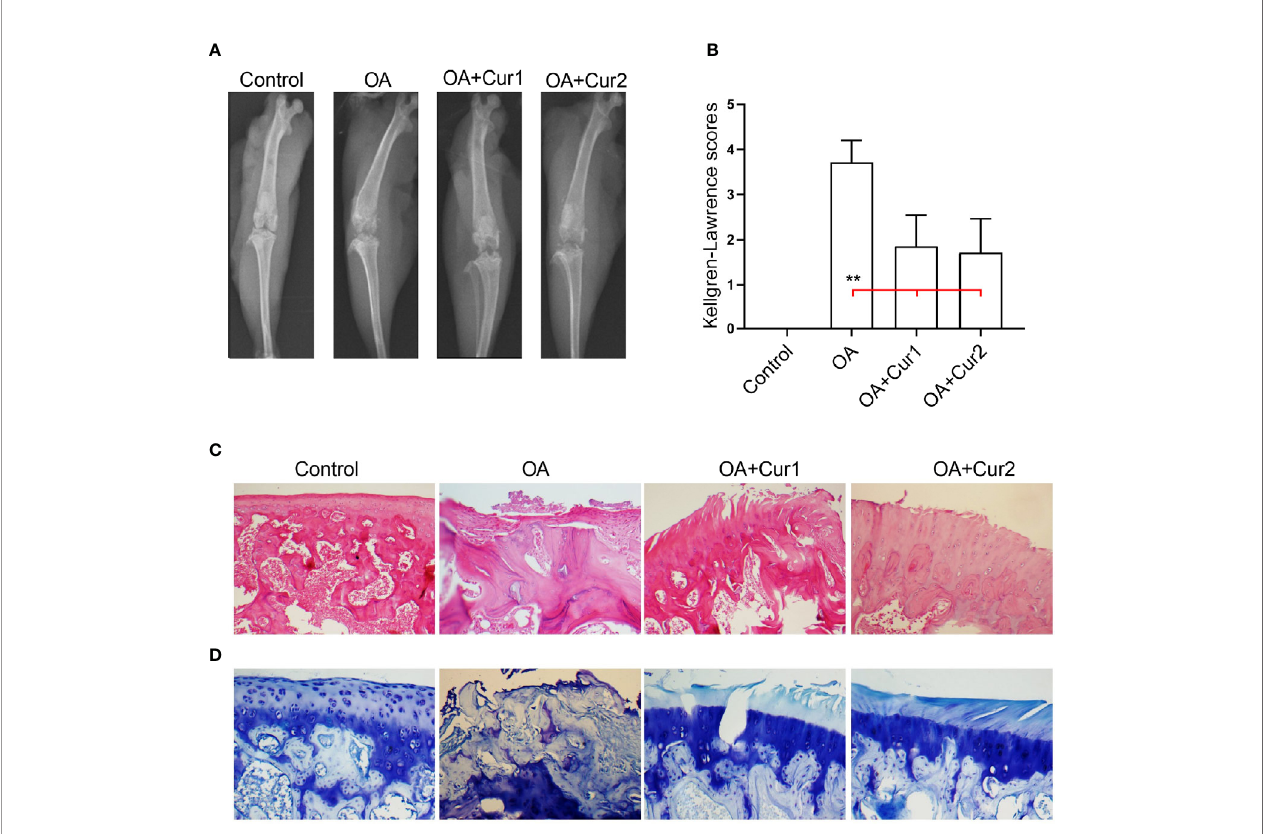
FIGURE 2 | Radiological and histological assessment of the knee joints in rats with monosodium iodoacetate (MIA)-induced OA after Next Generation Ultrasol Curcumin (NGUC) supplementation. (A) Representative radiographic images obtained at the end of the experiment are shown. (B) Mean values of Kellgren-Lawrence scores are demonstrated with ± SD (n=7 for each group). (C) Representative histopathological images of the hematoxylin and eosin staining in the indicated group of rats. (D) Representative histopathological images of the toluidine blue staining in the indicated group of rats. Statistical differences of the Kellgren-Lawrence scores among the groups were determined by a Kruskal-Wallis followed by the Mann-Whitney U test; ** p < 0.01. NGUC, next generation ultrasol curcumin; OA, osteoarthritis; OA+Cur 1, 100 mg/kg of NGUC; OA+Cur 2, 200 mg/kg of